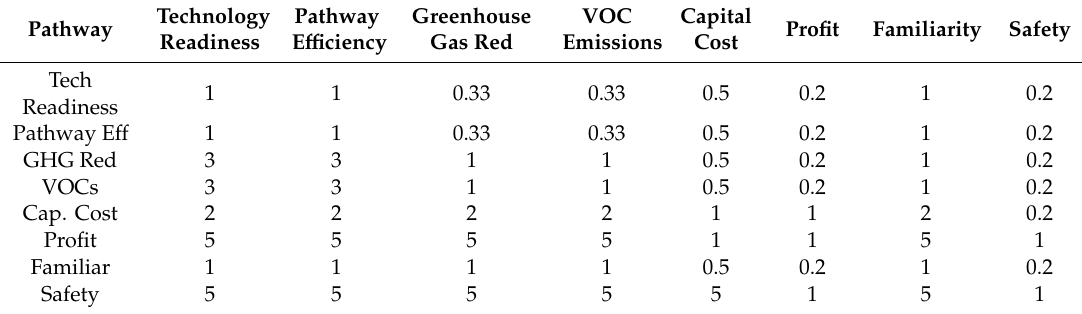
Table 19. Pairwise Comparisons for Focus on Profitability and Safety (Source: own results).